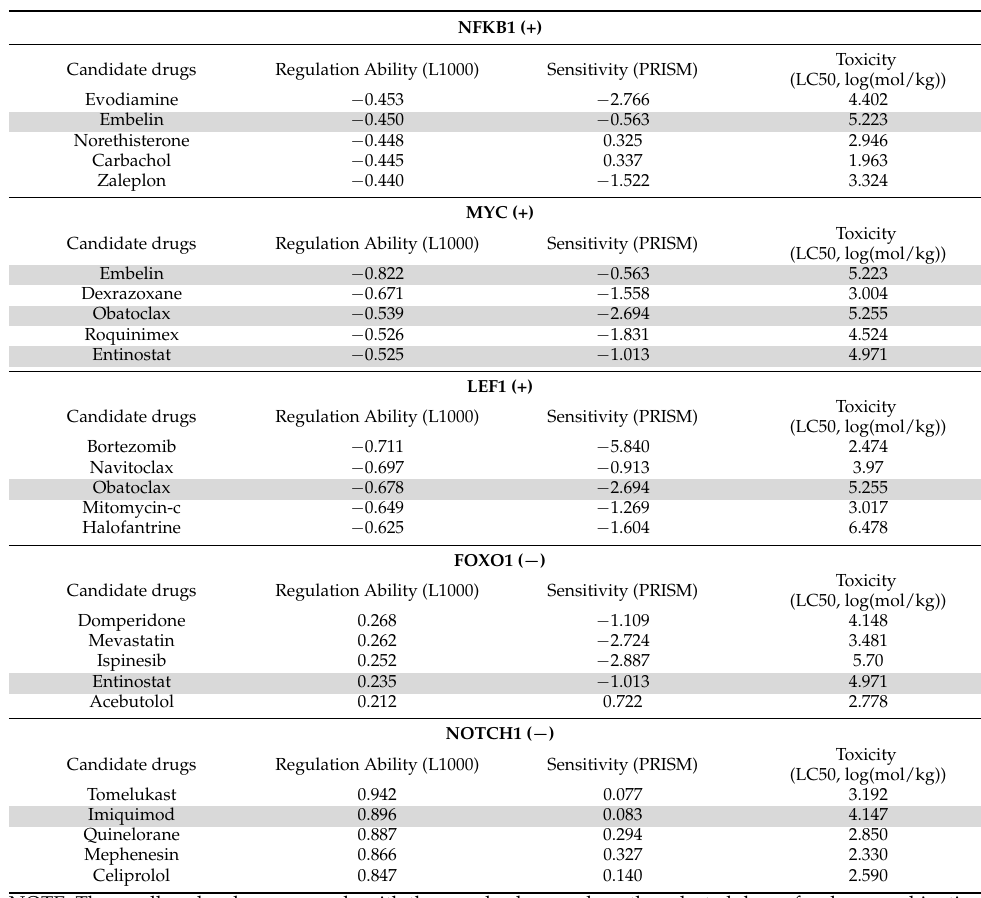
Table 1. Potential small-molecule compounds for each identified drug target of MIBC and ABC are selected from their candidate small-molecule compounds based on the drug design